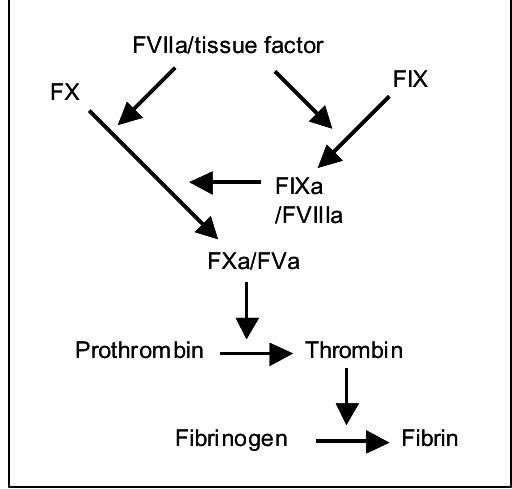
Fig. 1 – Simplified scheme of blood coagulation reactions. Ex- posure of tissue factor upon vascular damage leads to complex formationwithFVIIa(extrinsictenasecomplex). FIXandFXare subsequently activated. FIXa combines with the protein cofactor FVIIIa to form the intrinsic tenase complex that efficiently acti- vates FX. FXa combines with the protein cofactor FVa to form the prothrombinase complex, which activates prothrombin into